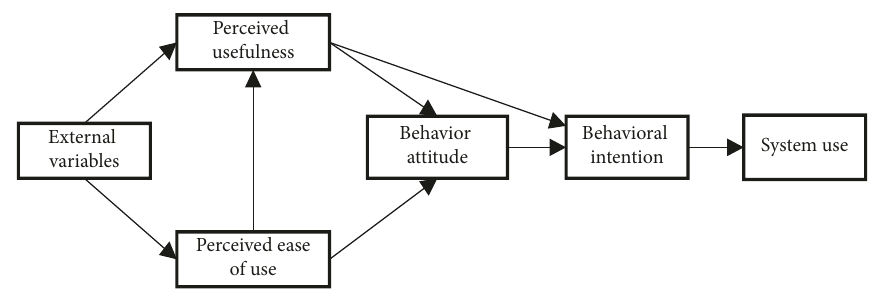
Figure 1: Framework of